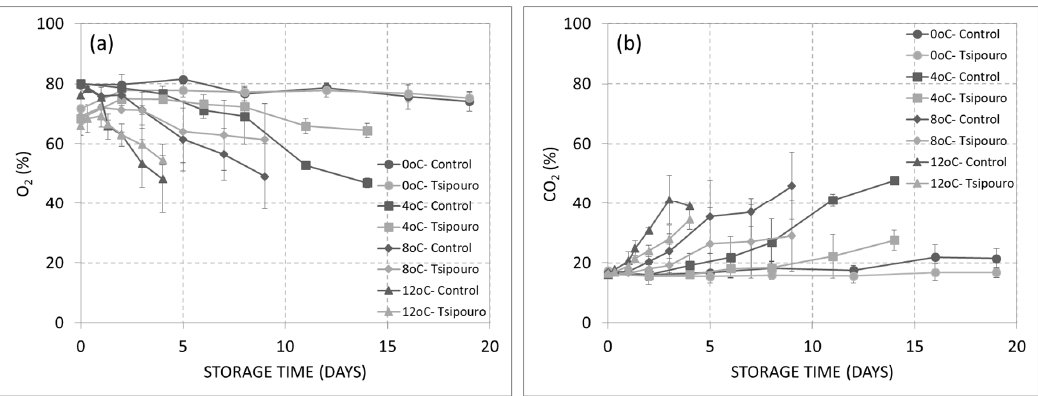
Figure 2. Evolution of ( a ) O 2 % and ( b ) CO 2 % on ground beef (500 g) packaged with absorbent pads supplemented with a total volume of 50 mL “ tsipouro ” (40 mL under the ground beef piece and 10 mL under the labelling, facing the headspace) and stored under 80% O 2 : 20% CO 2 at 0, 4, 8, and 12 °C. Untreated samples served as controls.